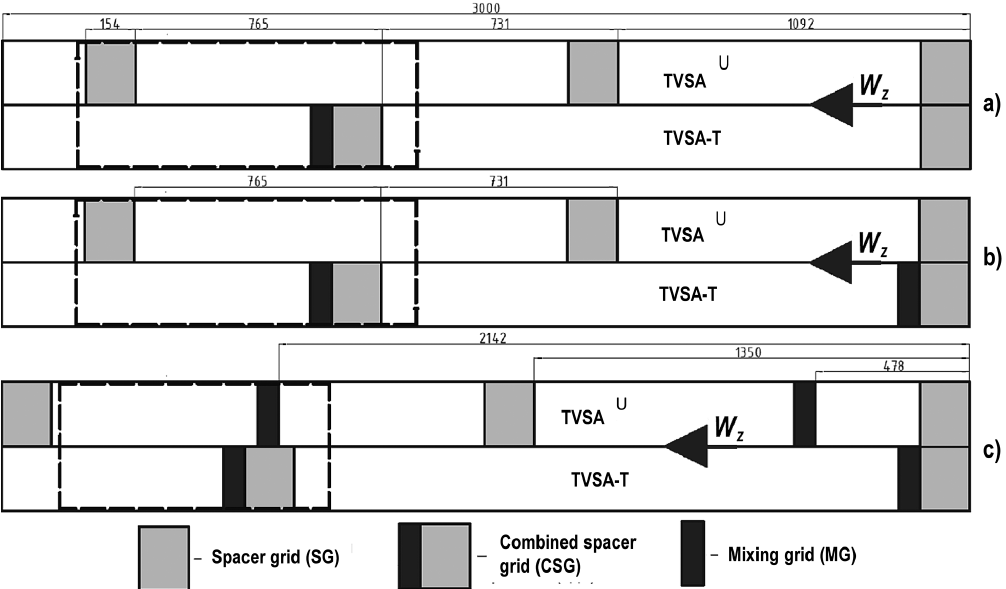
Figure 2. Grid arrangement in different portions of the TVSA fuel bundle: a) “lower” portion; b) “medium” portion; c) “upper” portion.